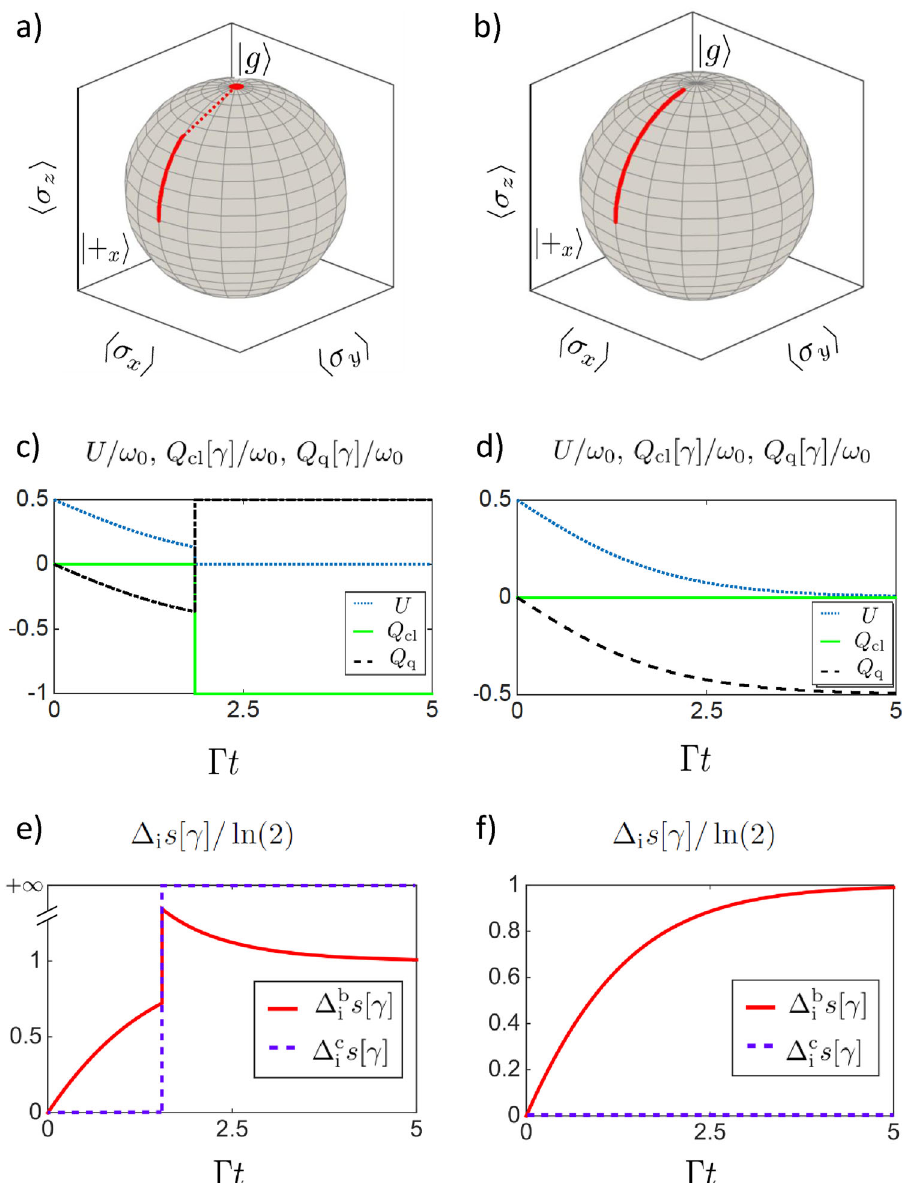
Fig. 3 Thermodynamics of spontaneous emission. A Qubit is prepared in the | + x 〉 state and coupled to a zero-temperature reservoir monitored with a photo-counter. a , b Quantum trajectories of the Qubit ’ s state in the Bloch sphere, in the case of a jump trajectory ( a ) and no- jump trajectory ( b ). c , d Internal energy, classical and quantum heat contributions in units of ω 0 as a function of time. We took (cid:1) h ¼ 1 . e , f two s ½ γ (cid:3) and Δ b s ½ γ (cid:3) , in unit of contributions to entropy production: Δ c i i